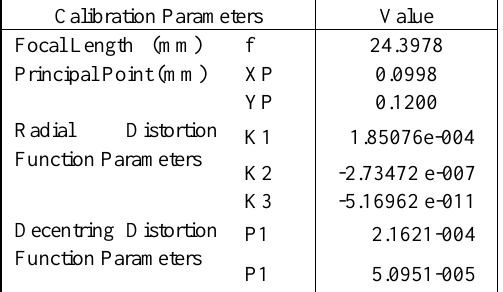
Table 1. Camera calibration parameters